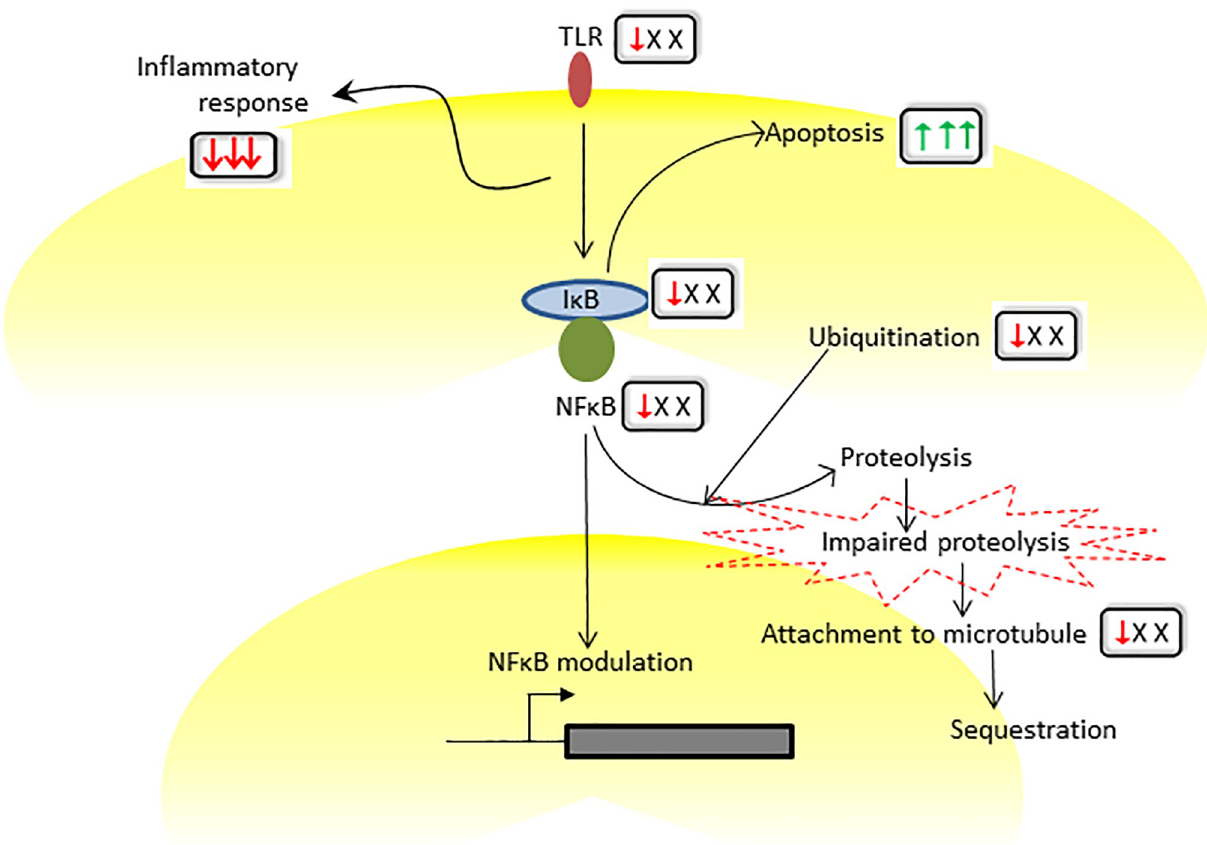
Fig 4. A pictorial representation of the cluster of networks that became susceptible to Y . pestis at 9 h p.i. The box adjacent to the gene/function represents the corresponding predicted level of regulations in submandibular LN, lungs and mediastinal LN, respectively at 9 h p.i. The predicted regulations of ubiquitin, microtubules and NF κ B were confirmed by investigating the time and tissue specific abundance of candidate proteins. The green upward arrow and red downward arrow represent the activation and inhibition, respectively. The ‘x’ stands for no change.